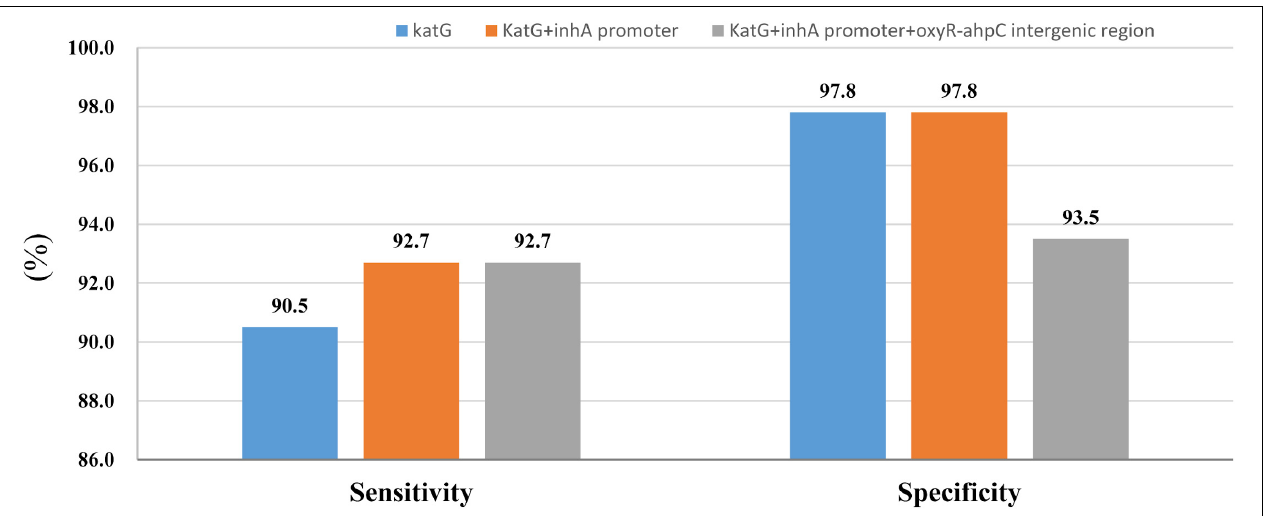
FIGURE 1 | Sensitivity and specificity of sequencing of katG combined with inhA promoter and oxyR-ahpC intergenic region for isoniazid resistance and susceptibility diagnoses.